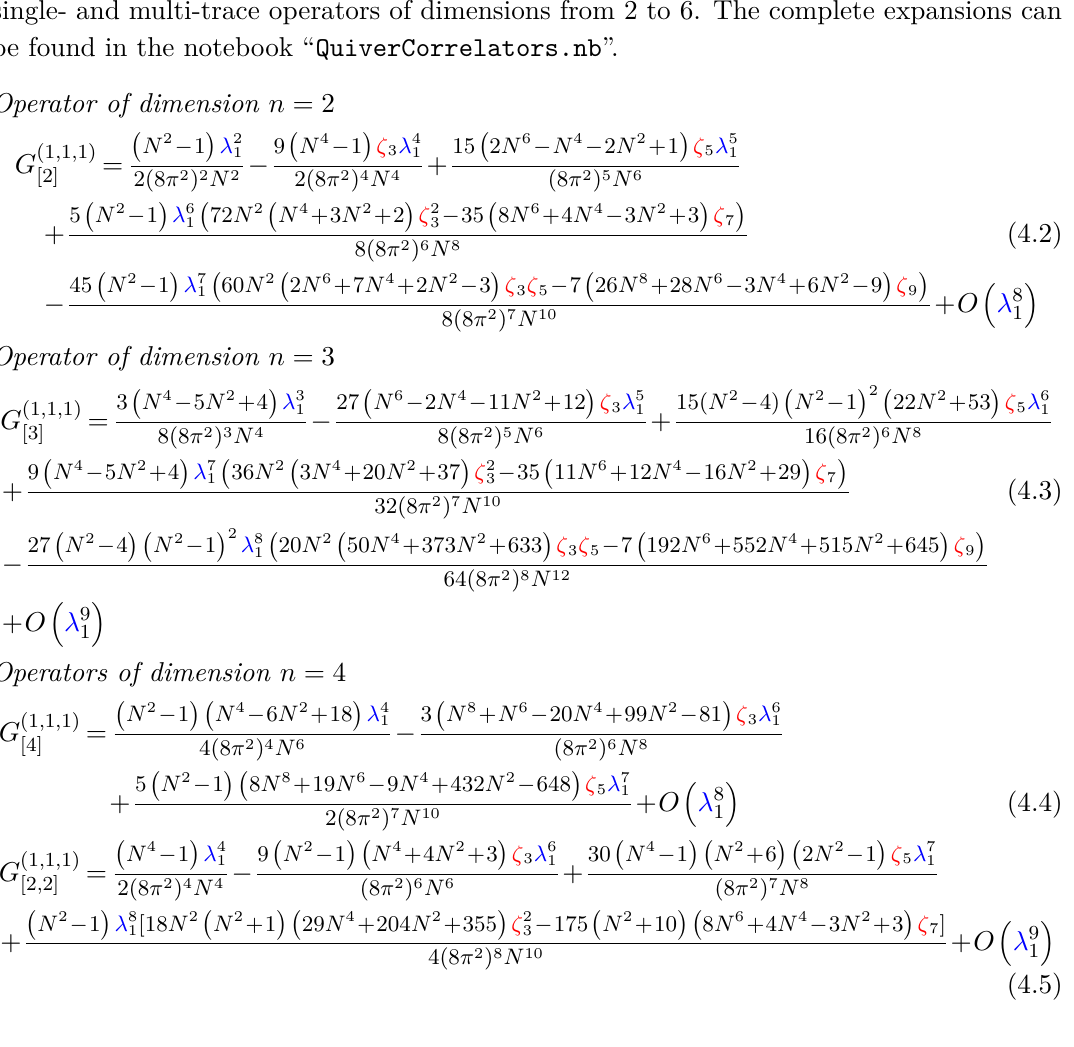
Figure 3. Quiver representation of SCQCD. The square nodes now represent the flavour